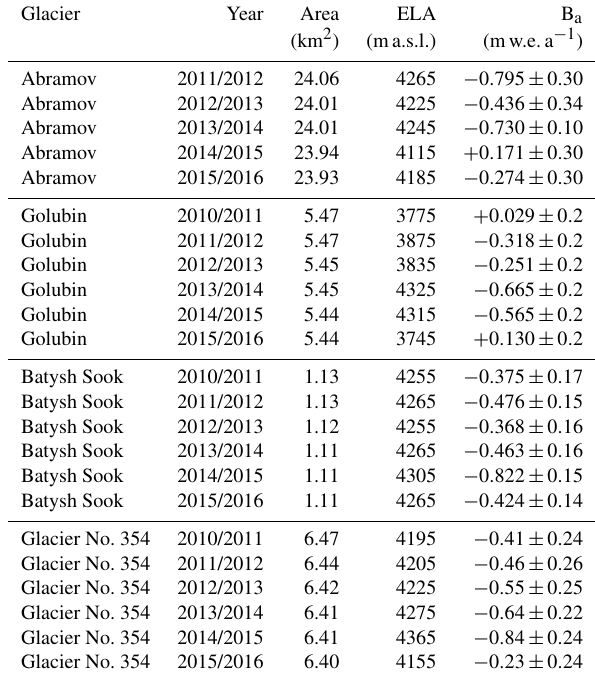
Table 3. Glaciological mass balance for Abramov, Golubin, Batysh Sook and Glacier No. 354 after the re-establishment of the measure- ments, calculated for the hydrological year using a mass balance model.